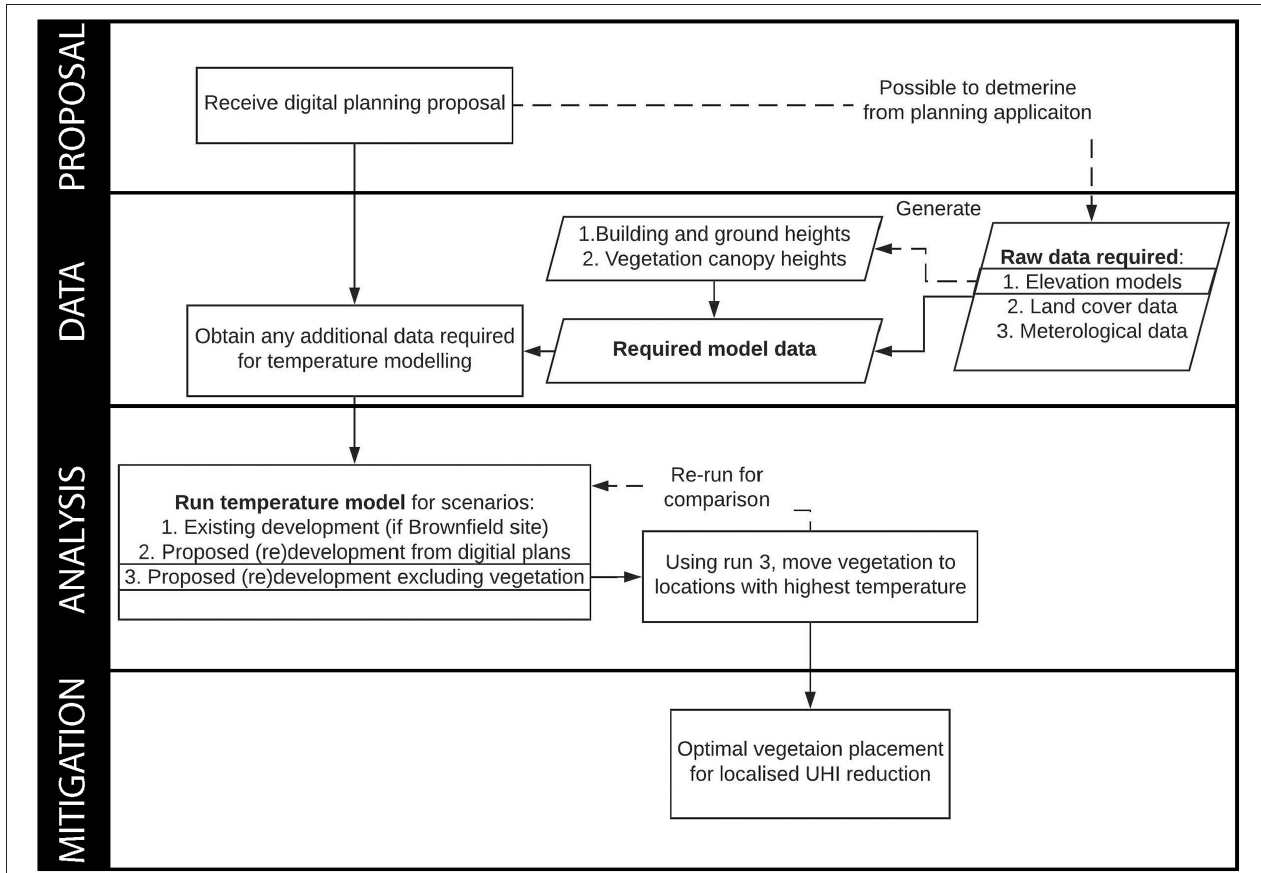
FIGURE 5 | Summary of the presented practical data-driven process for localized UHI mitigation.